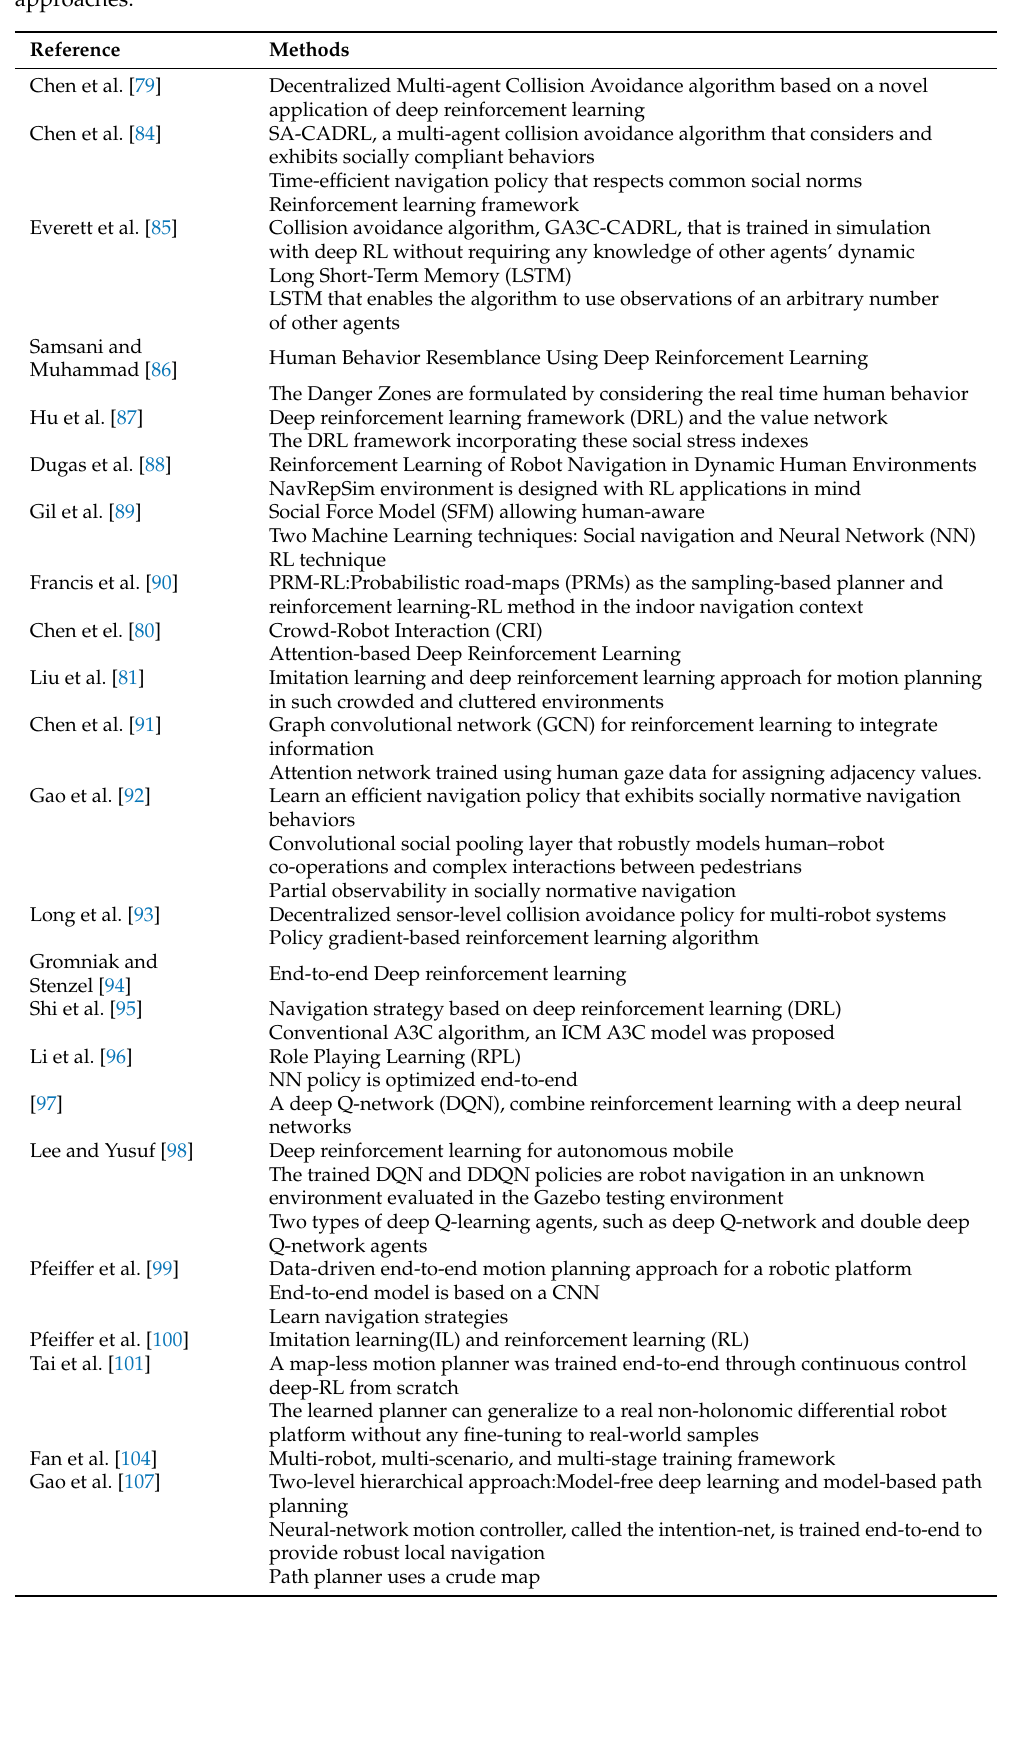
Table 4. Approaches considered in Section 3.3.1. The table covers the methods for DRL and E2E